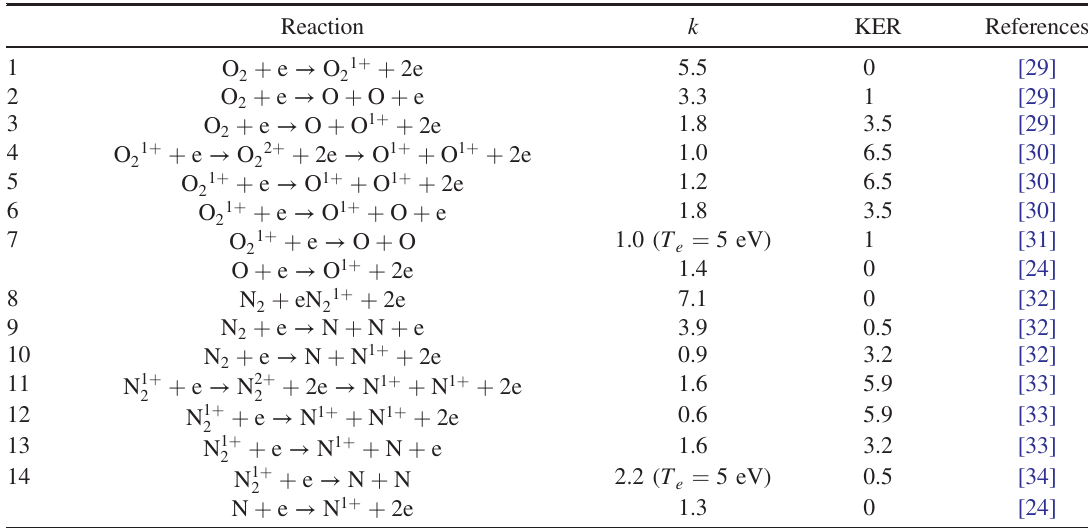
TABLE I. Ionization rates ( k , 10 − 8 cm − 3 = sec) and kinetic energy release (KER) per fragment [eV] for molecular ¼ 12 oxygen and nitrogen ( T ew